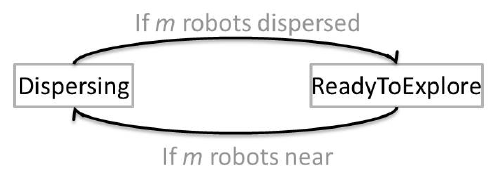
Figure 2. Implemented 2-state Finite State Automata for autonomous